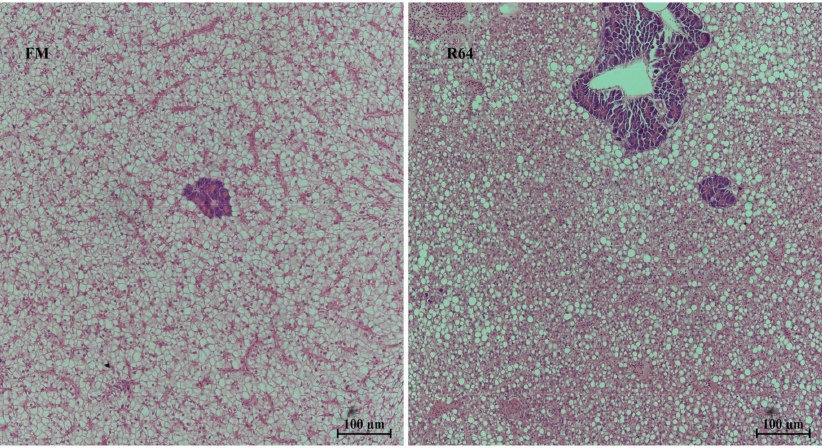
Figure 4. Liver histology (magnification 200 × ) of juvenile S. sihama .